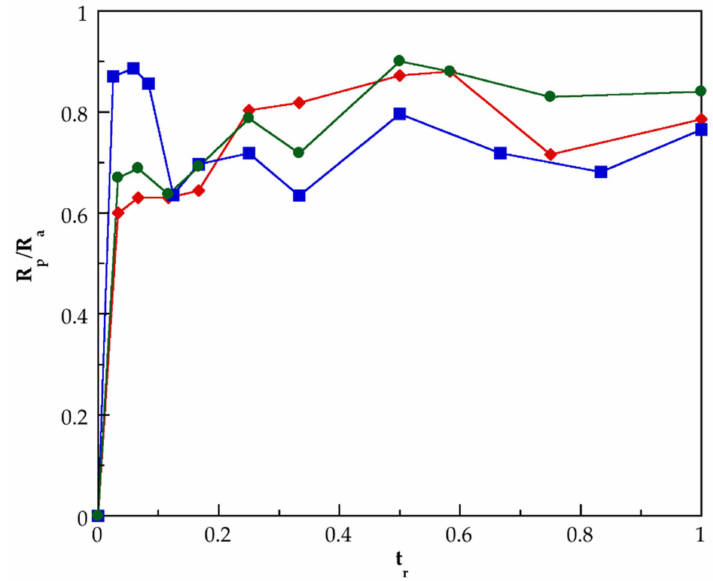
Figure 5. Development of the rate of polymerization to monomer feeding rate ( R p /R a ) in function of normalized time for polymerization of MAA to synthesize the PMAA 6 ( (cid:4) ) or for the polymerization of a mixture of MAA and G 3.0 -CNTs-PAMAM-NH 2 to prepare the nanocomposites PMAA–CNTs